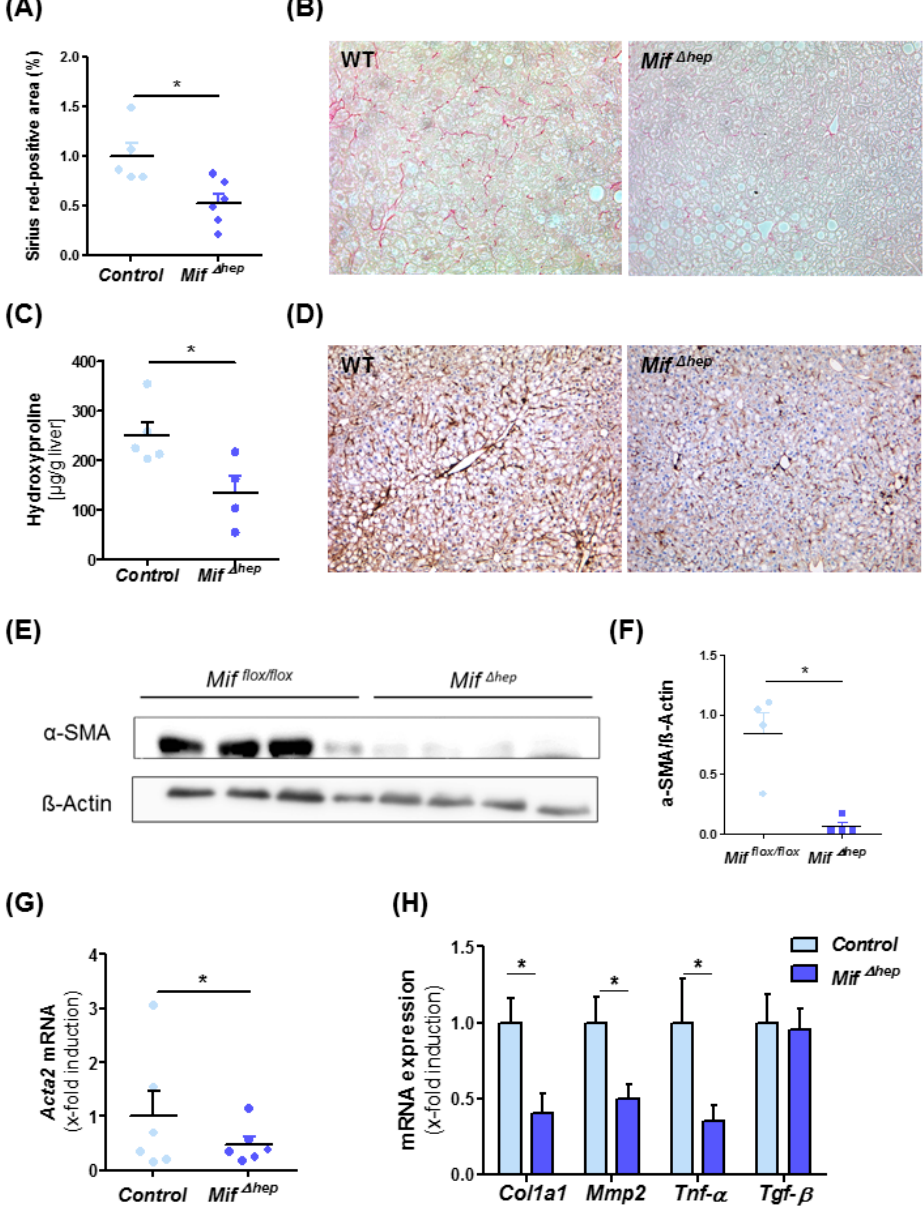
Figure 4. Decreased liver fibrosis progression in Mif ∆ hep mice after experimental NASH model. ( A ) Quantification and ( B ) representative Sirius red stainings of Mif ∆ hep and control littermates mice after 8 weeks of MCD feeding. Sirius-red stainings were quantitated using ImageJ software. ( C ) Biochemical measurement of amino acid hydroxyproline from snap-frozen liver tissue confirmed the decreased fibrosis level within the liver. ( D ) Representative immunohistochemical α -SMA stainings of Mif ∆ hep mice and control littermates after 8 weeks of MCD feeding and ( E , F ) Western blot analysis on whole liver tissue using antibodies against α -SMA, ß-Actin served as loading control. ( F ) Relative α -SMA protein level. ( G ) Hepatic stellate cells (HSC) activation is determined by mRNA expression level via qRT-PCR ( n = 6 per group). ( H ) Expression patterns of fibrosis-related genes, e.g., Col1a1 , Mmp2 , Tnf- α , and Tgf- β were measured by qRT-PCR between Mif Δ hep mice and control littermates ( n = 6 per group). Asterisks indicate statistical significance: * p < 0.05.